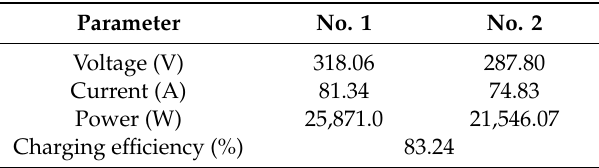
Figure 6. The actual experiment of power transfer capacity of L-module: ( a ) Instrument system setup (NCP: Non-contact power supply), ( b ) schematic diagram for overall setup of experiment (ATS: Automatic transfer switch), ( c ) effective distance of wireless power (15 mm) with charging efficiency of 83.24%. Table 2. Parameters related to power level between No.1 and No.2 shown in Figure 6a, and charging e ffi ciency (83.24%), which was measured based on 20